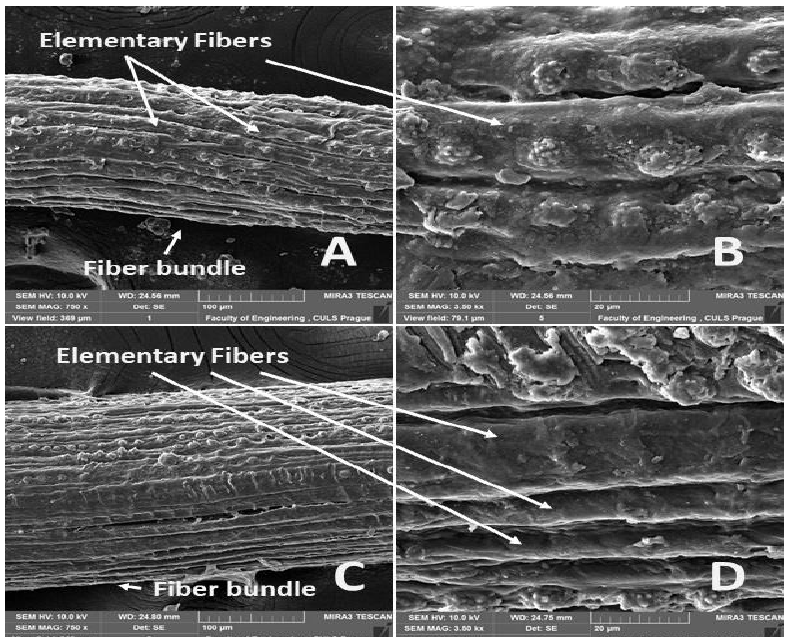
Figure 9. SEM images of the surfaces of abaca and coir fibers with treatment in a 5% solution of NaOH for 12 h: ( A ): abaca fiber bundle (MAG 750 x), ( B ): detailed view of the surface of an abaca fiber (MAG 3.50 kx), ( C ): coir bundle (MAG 750 x), ( D ): detailed view of the surface of a coir fiber (MAG 3.50 kx).